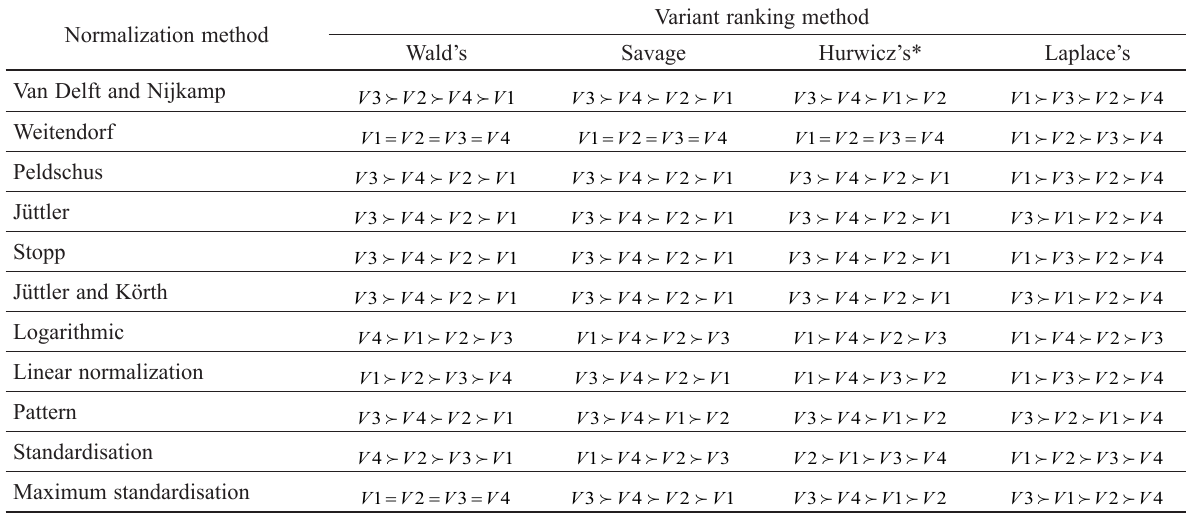
Table 4. Variant ranking according to the analysed methods without taking criteria weights into account Variant ranking method Normalization method Wald’s